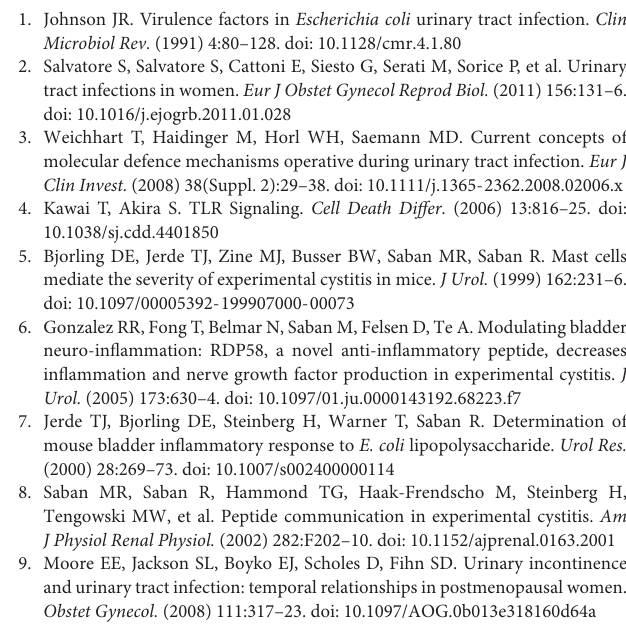
FIGURE S1 | TRPV4 is not required for the LPS-induced nuclear translocation of the p65 subunit of NF- κ B in mouse urothelial cells. Single-color confocal images of NF- κ B p65 (red) and DAPI nuclear staining (blue). The corresponding merged images are shown in Figure 5A . Scale bar, 10 µ m. FIGURE S2 | TRPV4 is not required for the LPS-induced phosphorylation of S534 p65 subunit of NF- κ B in mouse urothelial cells. Representative confocal immunofluorescence microscopy images of fixed mUCs in control or 30 min after treatment with LPS (20 µ g/ml). Cells were stained with phospho p65 NF- κ B (red) and DAPI nuclear staining (blue). Scale bar, 10 µ m. The histograms show the corresponding pixel intensity distribution (8-bit scale) of phospho p65 NF- κ B staining in the cytoplasmic area (gray-shaded bars) or within the nuclear area (blue bars). Ratios represented in Figure 5C were calculated using the mean intensity values from the pixel intensity distribution in these two